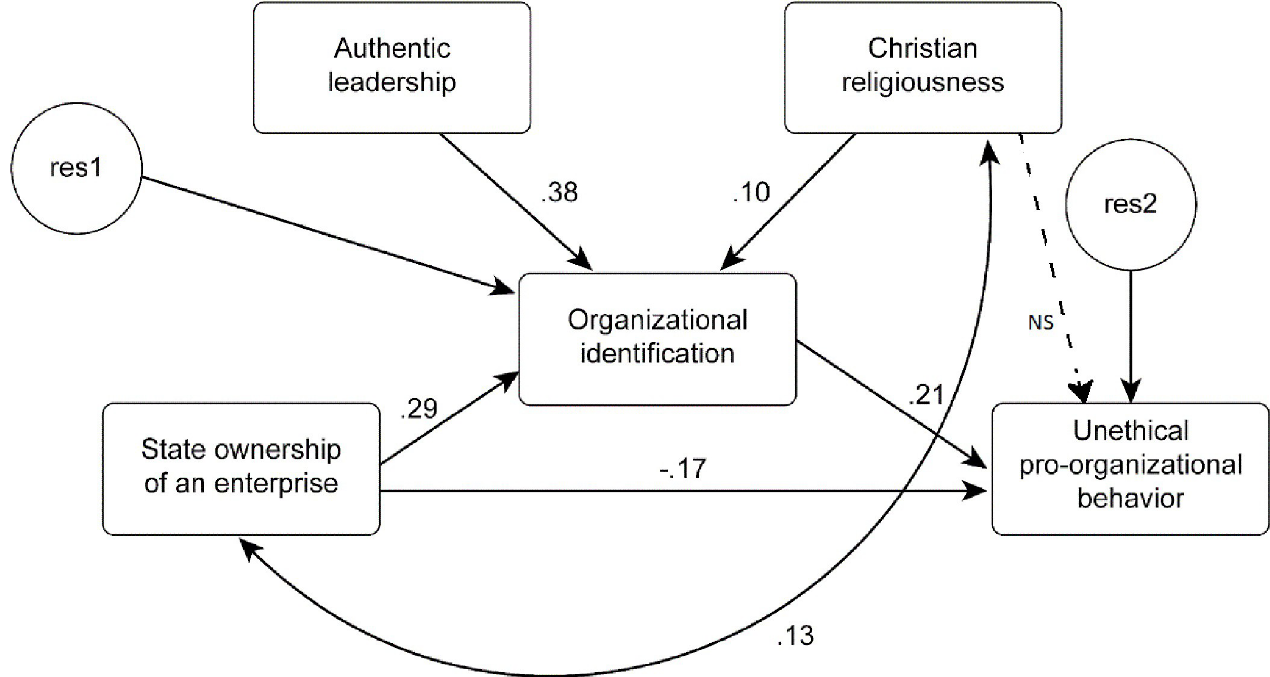
Fig 3. The obtained model of correlations among the variables. Source: own work based on the research results.